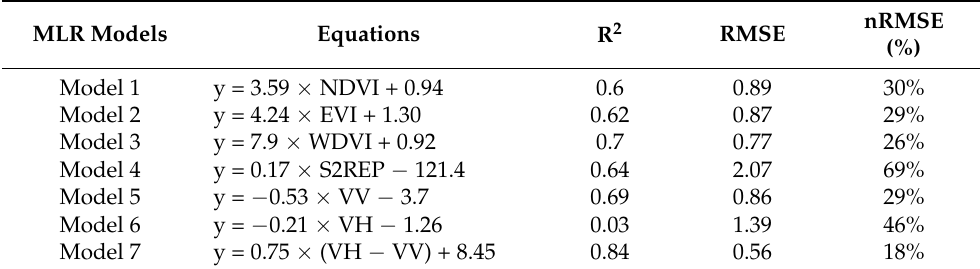
Table 5. Phenological models for wheat using optical / SAR remote sensing indices.